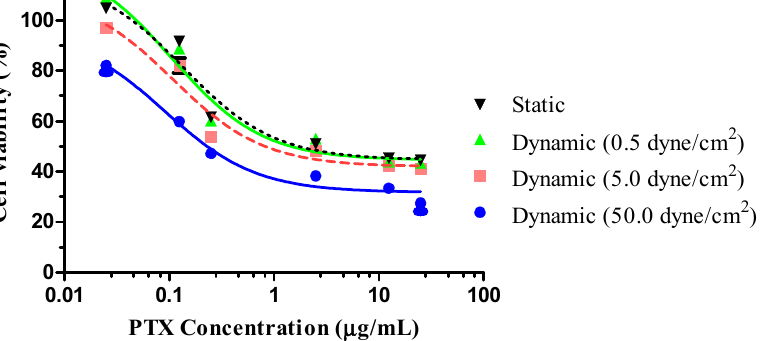
Figure 7. Cell viability of A549 cells treated with PTX-GONs under different cell culture conditions incubated for 24 h (data are expressed as mean ± SD for triplicate experiments, n = 6).